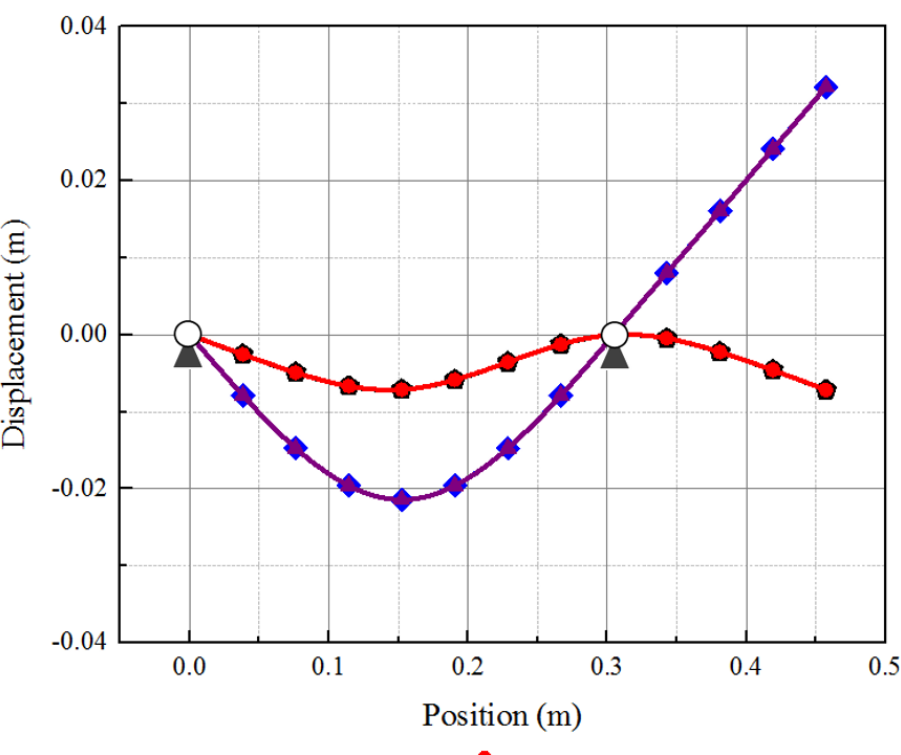
Figure 10. Deformed shape of the beam. ( Normal mode approach (free-free modes), CB matrix (free-free modes), ANSYS (simply-supported modes), and Improved CB matrix (simply-supported modes)).